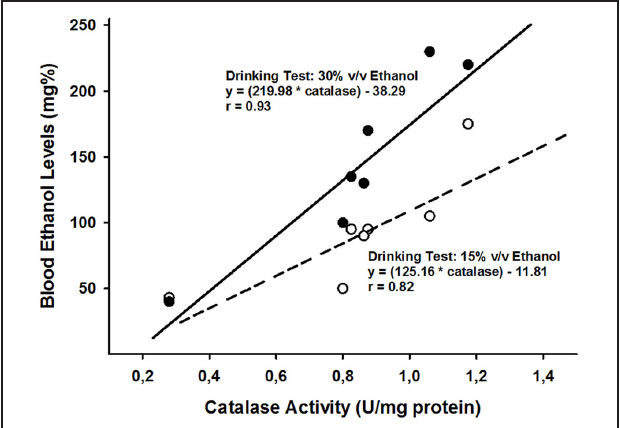
FIGURE 2 | The figure illustrates regression lines and linear correlations when taking into account catalase activity levels (U/mg protein; data derived from the study of -Del Maestro and Mcdonald, 1987-) and blood ethanol levels attained in alcohol drinking tests performed with either 15 or 30% v/v ethanol (data derived from Truxell and Spear, 2004; Truxell et al., 2007). In order to perform these correlations, catalase and blood ethanol levels were calculated for the following postnatal days: 12, 18, 22, 25, 28, 30, and